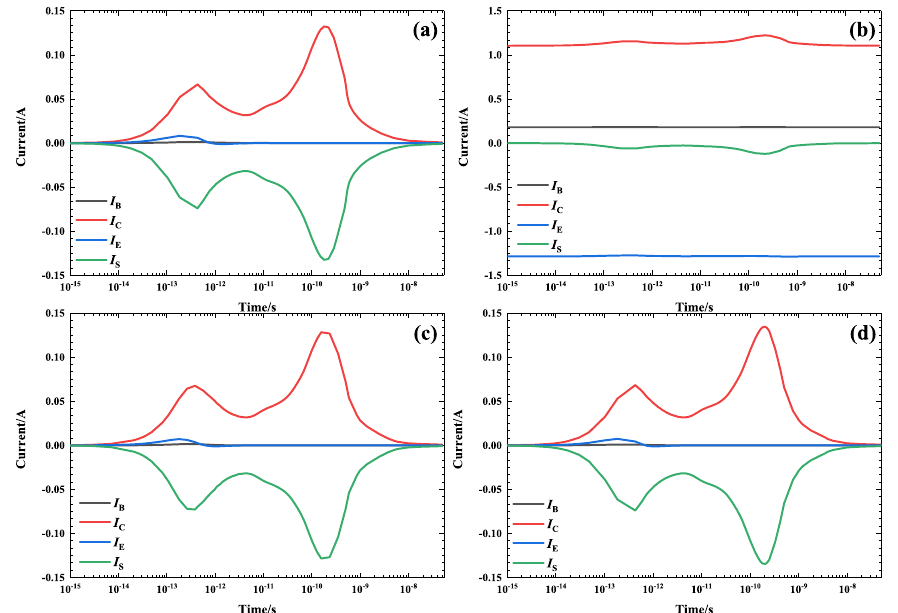
Figure A3. Change in current with time when heavy ions vertically irradiate the substrate of the SiGe HBT under the substrate inverse bias ( a ), positive bias ( b ), off bias ( c ) and collector positive bias ( d ) states.